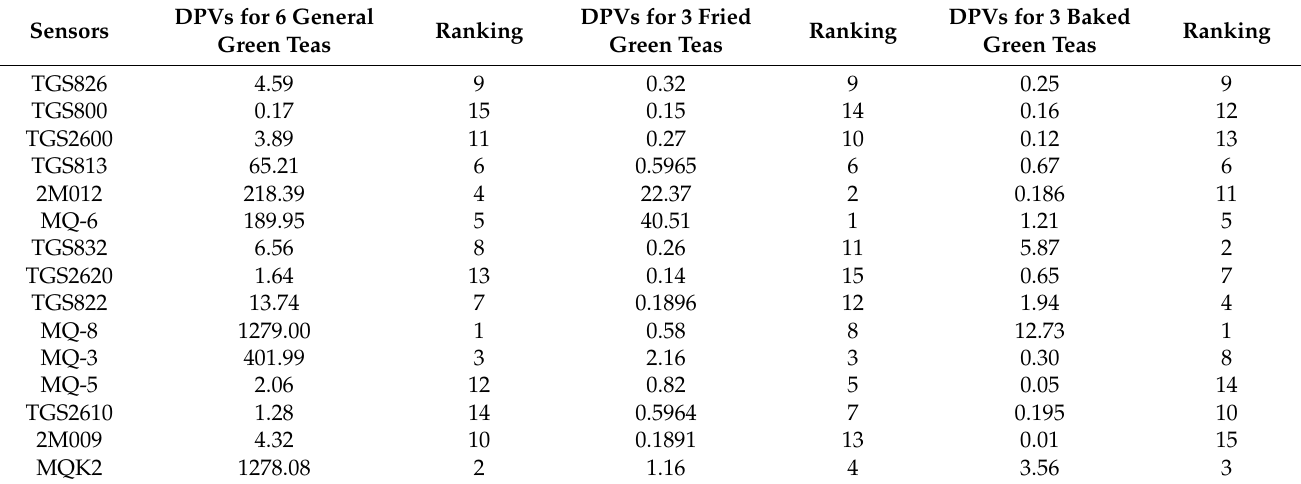
Table 4. Sensors’ DPVs for different kinds of green tea.